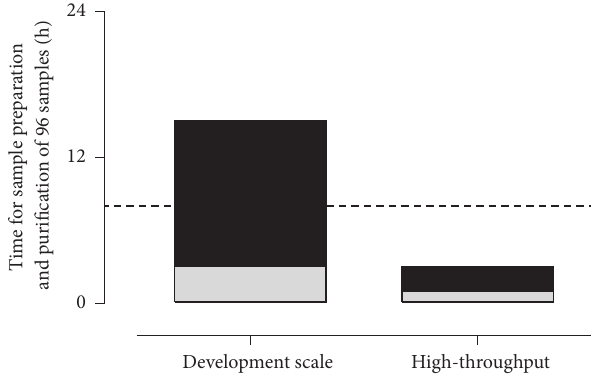
Figure 7: Comparison of required time for bioanalysis between development scale by applying single cartridges and the high- throughput approach with 96-well plate. The calculation bases on a sample amount of 96 samples. The black areas mark the required timeforsamplepurificationbysolid-phaseextractionandgreyareas identify the time frame required for sample preparation. The dashed line represents one full working day (8 hours). By applying the high-throughput approach the sample preparation and purification is finalized within 2 hours while the same amount of samples is impossible to purify within one working day by one lab technician using the previous development